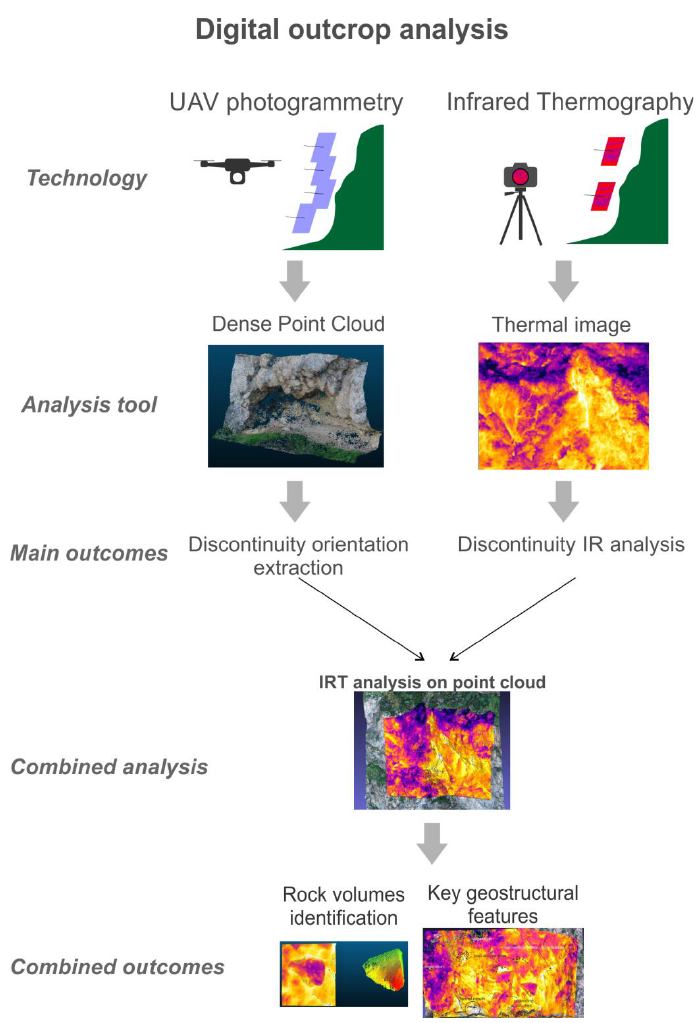
Figure 2. S ummary and schematization of the methodological approach carried out for this study. Figure 2. Summary and schematization of the methodological approach carried out for this